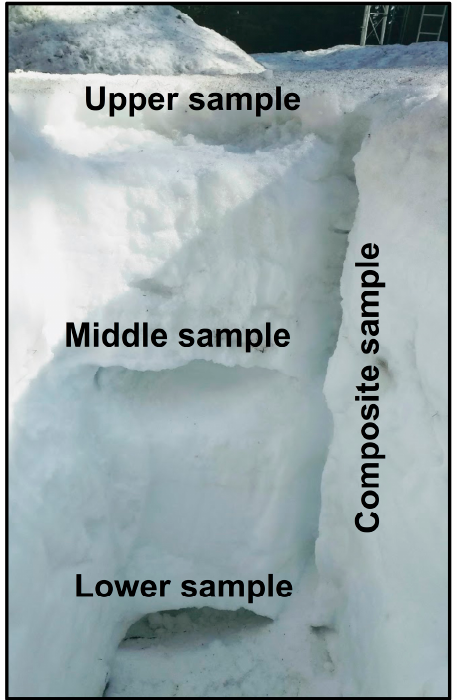
Figure 8. Snow collection at snowpack face from trenching along the sample transect (upper, middle, lower, and composite sample regions labeled).